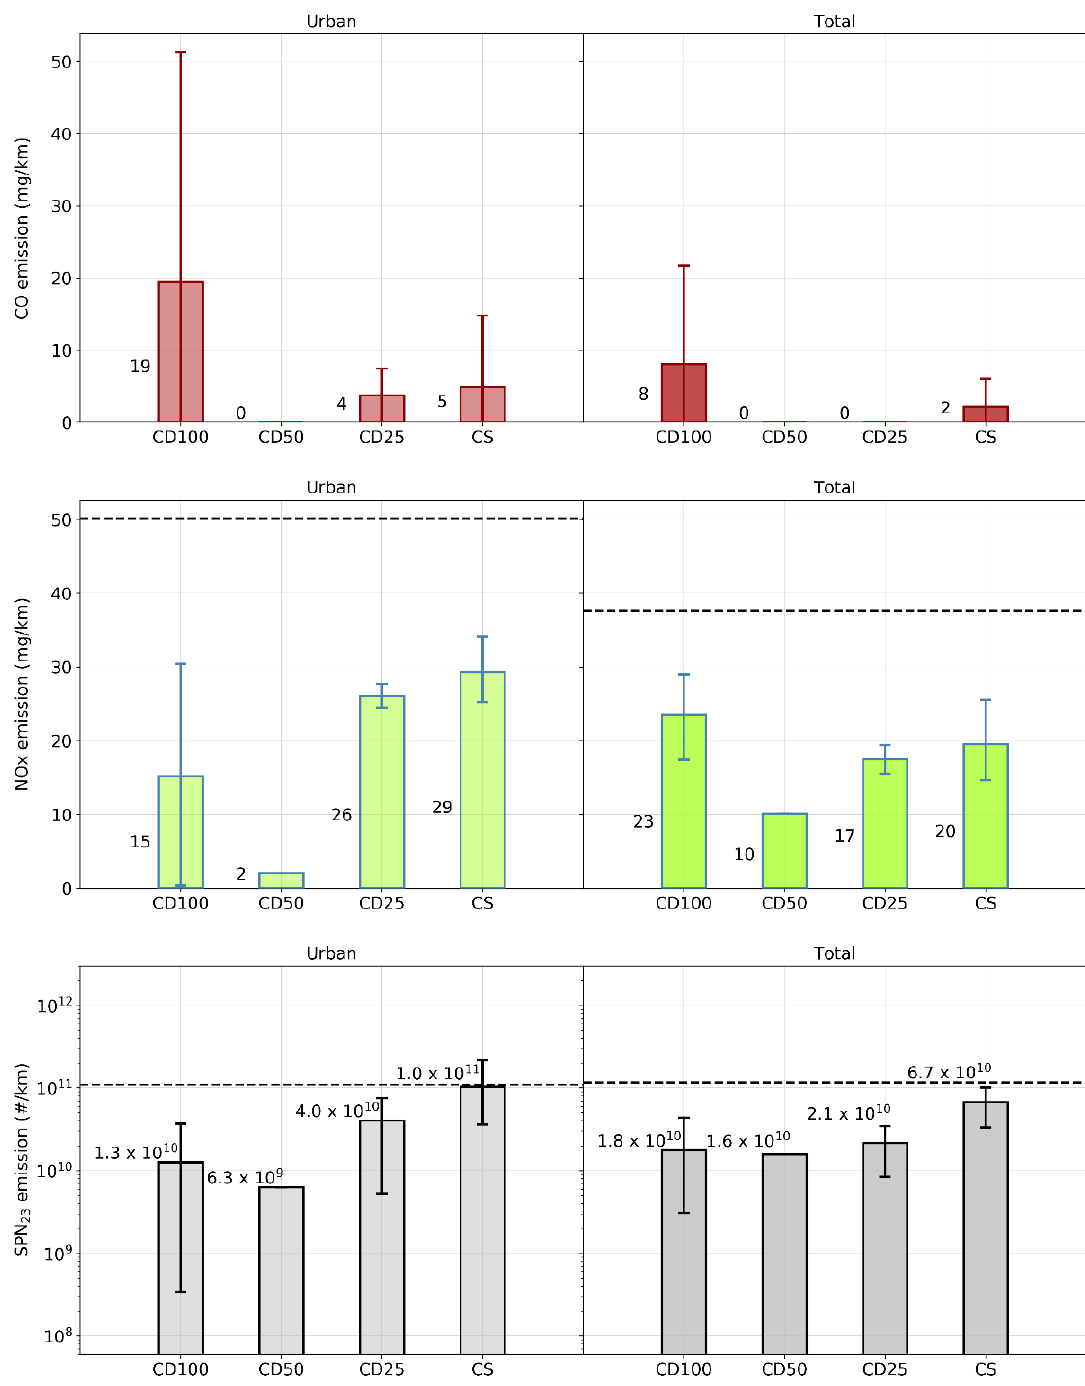
Figure 2. Regulated emissions on RDE compliant tests. CD100/50/25 indicate charge depleting operation with battery initial state of charge (SOC) equal to 100/50/25%; CS indicated charge sustaining operation, i.e., starting with the minimum SOC. Left panels report emissions for the urban phase, right panels for the complete test. Black dashed lines represent average emissions from the fleet of Diesel vehicles tested at the JRC in the 2020–2021 period in the framework of Market Surveillance and are not reported for CO. All tests were performed in the default user selectable mode of operation. Error bars on the graph represent maximum and minimum values for conditions having more than one test. See Methods section for additional